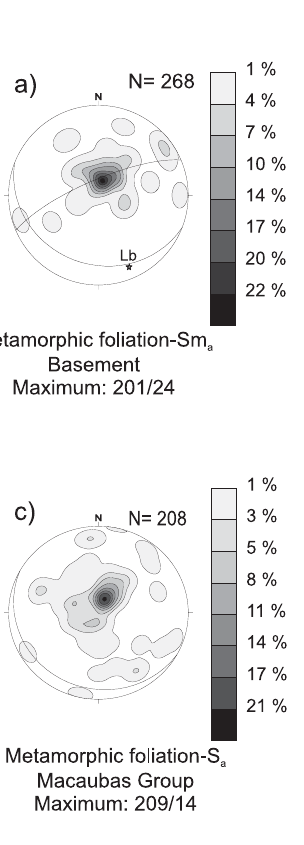
Fig. 11 – Equal-area, lower hemisphere stereonet plots of poles to foliations and lineations of the Rio Pardo salient of the Araçuaí